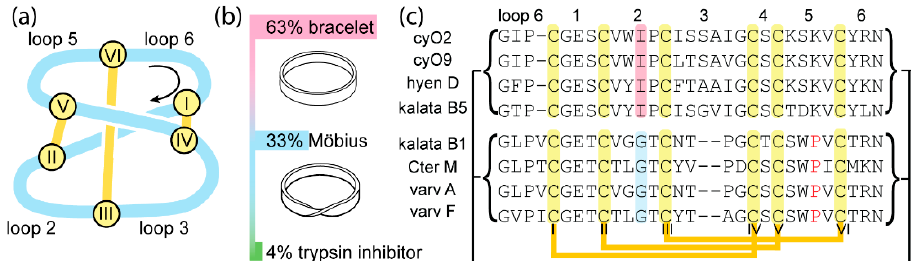
Figure 1. Cyclotide topology, relative abundance of subfamilies, and sequence alignment of selected cyclotides. ( a ) Illustration of the cyclic cystine knot (CCK) motif that defines cyclotide topology. The yellow circles represent cysteine residues, labelled with Roman numerals according to their sequential order. ( b ) Bar chart showing the relative abundance of each subfamily. ( c ) Sequence alignment; orange and black lines represent disulfide bonds and the circular backbone, respectively. Cysteine residues are highlighted in yellow. The Pro residue in loop 5 of Möbius cyclotides that adopts a cis conformation is in red. The third residue in loop 2 of each sequence is thought to be essential for in vitro folding and is highlighted in pink (bracelet) or blue (Möbius). CyO2 and cyO9 are cycloviolacin O2 and O9, respectively. CyO2 and kalata B1 are prototypical members of the bracelet and Möbius subfamilies. Trypsin inhibitor cyclotide sequences are omitted for clarity.